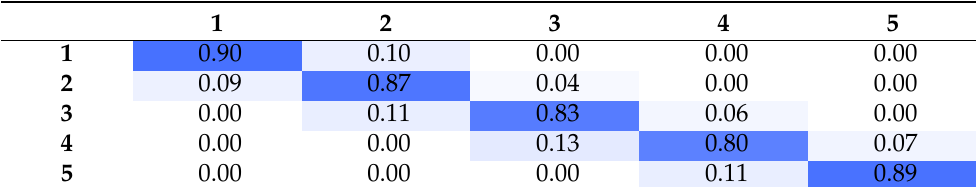
Table 5. Transition probability matrix: speed to speed.